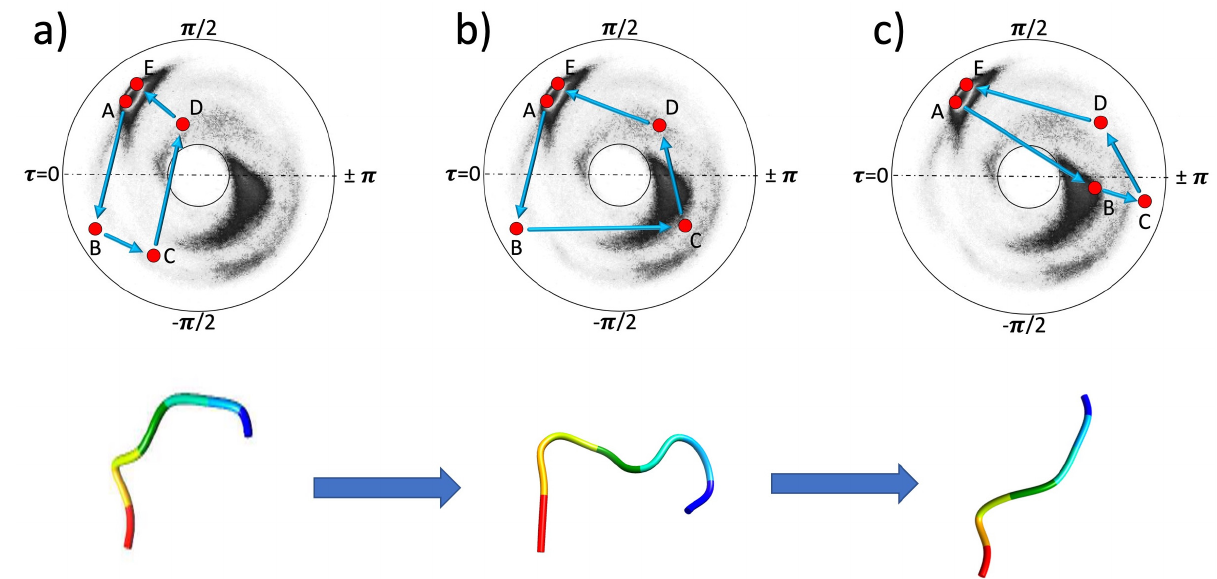
Fig 3. Different local topologies for a chain with five vertices. a) With two crossings of the flattening point line τ = 0. b) With one crossing of the flattening point line τ = 0 and one crossing of the line of β -flattening points τ = ± π . c) With two crossings of the line of β -flattening points τ = ± π . In both a) and c) the folding index Eq (17) vanishes but in b) the folding index has value -1 since the trajectory encircles the disk center once in counterclockwise direction. The attached 3D figures show the corresponding structures, ordered according to A = blue and E =